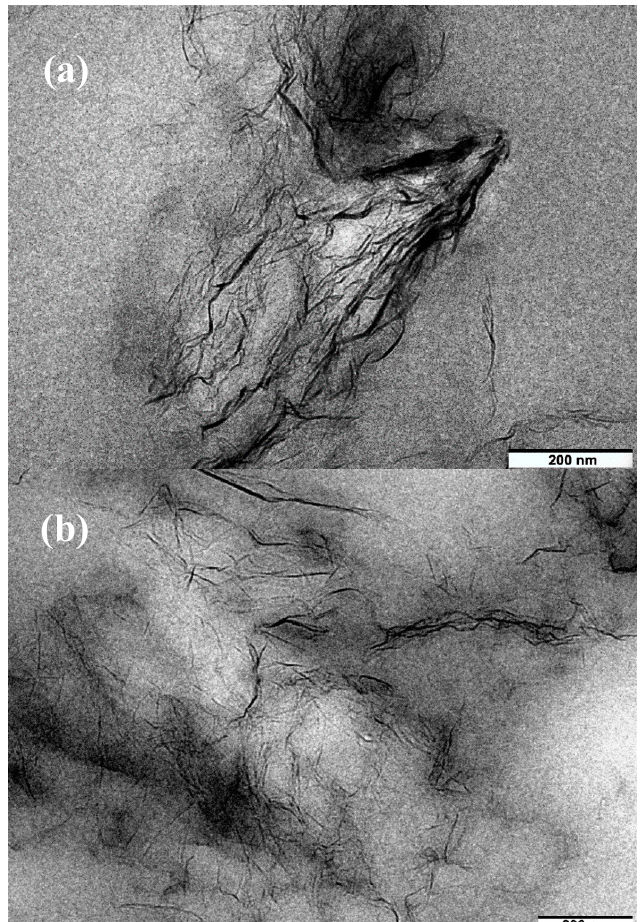
Figure 4 . Transmission electron microscopy of NR/rGO 3 wt.% ( a ) and w-NR/rGO 3wt.% ( b ).